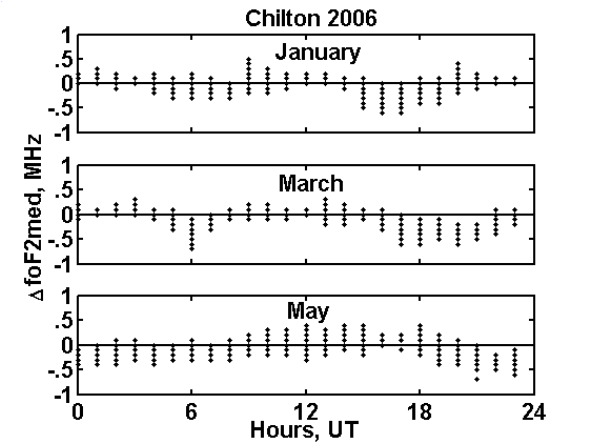
Fig. 2. Comparison of cloned fcF2 data at Rome produced from the parent observations at San Vito with actually observed foF2 data at Rome for the 1-monthly positive most disturbed day and the 1- monthly negative most disturbed day during all the months of